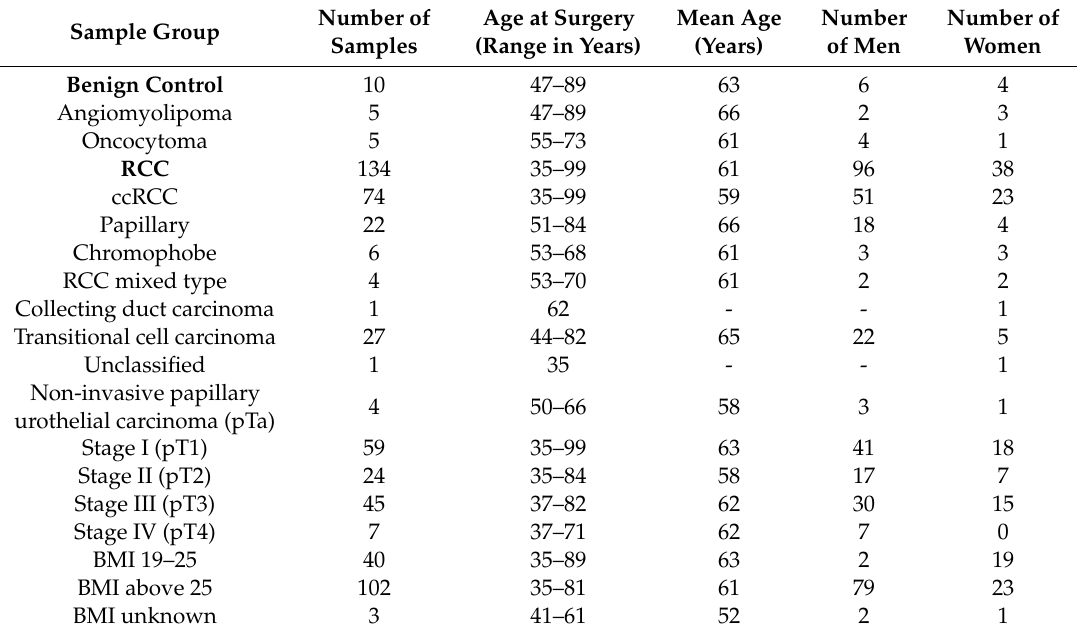
Table 1. Clinicopathologic characteristics of 145 patients with renal masses undergoing metabolomics analysis. RCC: Renal cell